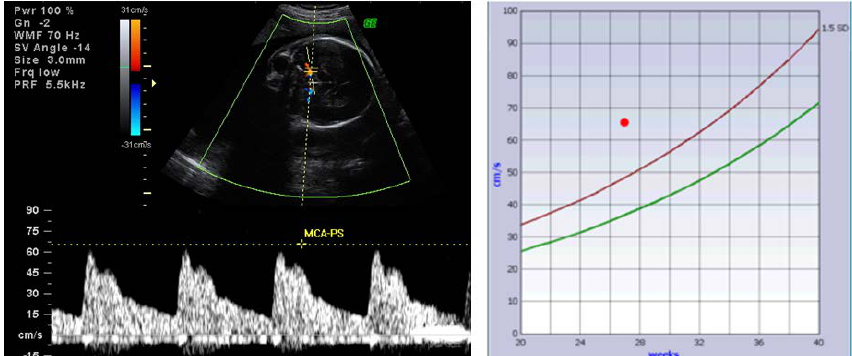
Figure 5. Pulsed Doppler examination showing increased peak systolic velocity on the middle cerebral artery ( left ); When plotted on the graph ( right ), the peak systolic velocity on the middle cerebral artery in this case (red dot) is higher than the limit of 1.5 standard deviation (red line); the green line represents the median peak systolic velocity for gestational age (collection of Filantropia Hospital).